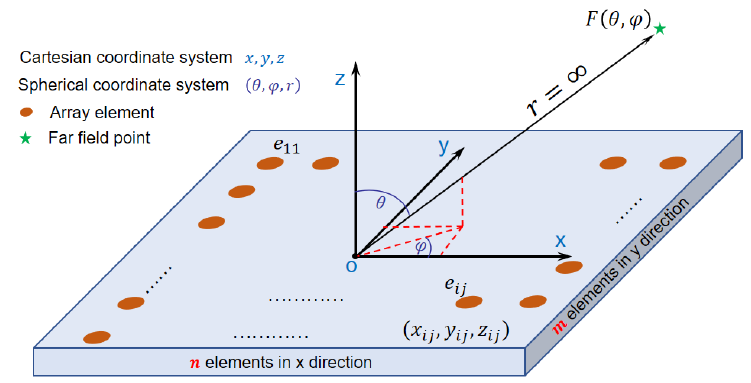
Figure A1. The pattern of the array antenna.